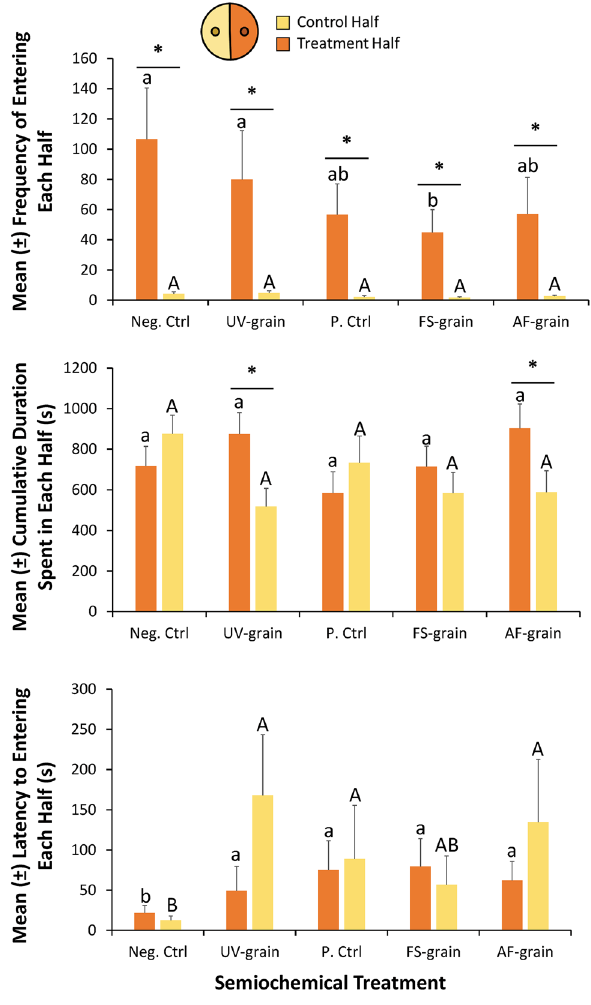
Figure 4. Treatment (orange bars) and control (yellow bars) zone metrics from the movement assay, including determining how MVOCs affect the mean (± SE) frequency of entering each zone (top panel), the cumulative duration spent in each zone (middle panel), and the latency to finding and entering each zone (bottom panel) by adult L. serricorne for a period of 30 min using video-tracking with a network camera coupled with Ethovision Software in the laboratory at the USDA-ARS Center for Grain and Animal Health Research in Manhattan, KS. The treatment zone contains a single hard winter wheat kernel, while the control zone does not contain any stimuli (neg. ctrl). There was a total of n = 20 replicate adults tested per treatment, translating to 50 h of data in this assay. Upper case letters represent multiple comparisons among levels of the control zones only, while lower case letters represent multiple comparisons among levels of the treatment zones only. Bars with shared letters are not significantly different from each other (Tukey HSD, α = 0.05). Asterisks (*) indicate post-hoc comparisons using paired t-tests (with Bonferroni correction), and only significant results have been displayed on applicable bars. Neg. Ctrl, negative control; UV-grain, UV-sanitized grain; P. Ctrl, uninoculated grain; FS-grain, F. verticillioides -inoculated grain; AF-grain, A. flavus -inoculated